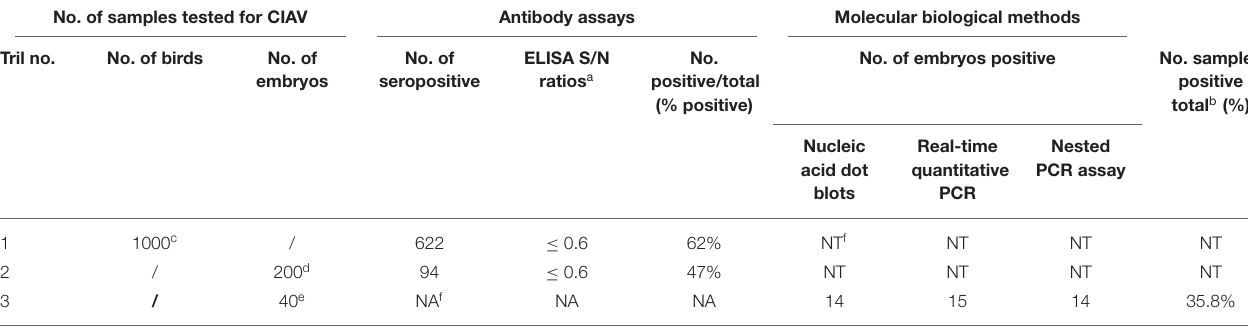
TABLE 3 | Detection of chicken infectious anemia virus by antibody assays and molecular biological methods. No. of samples tested for CIAV Antibody assays Molecular biological methods Tril no. No. of birds No. of